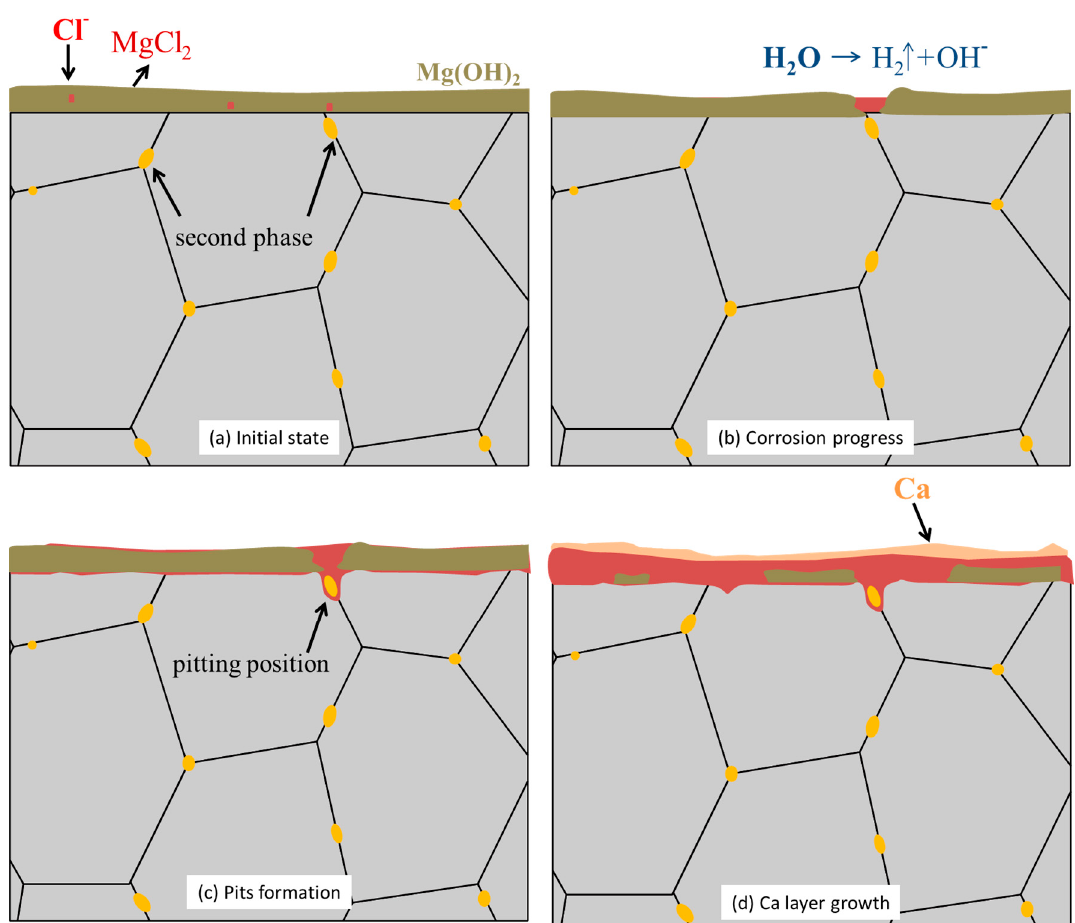
Figure 10. Illustration of corrosion mechanism of ZKX500 Mg alloy.